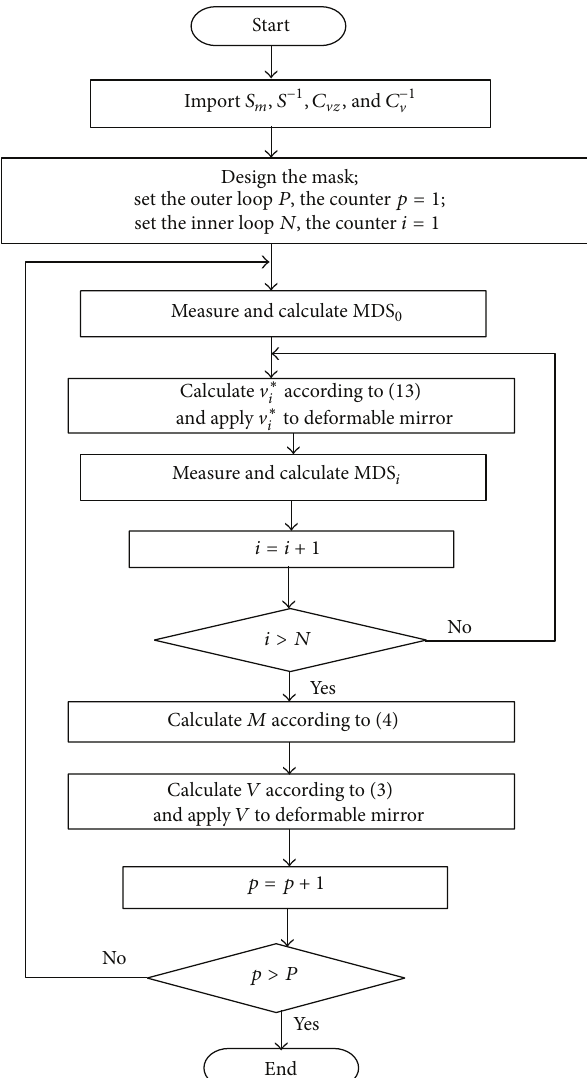
Figure 1: The flow chart of control algorithm for wavefront-sensor- less adaptive optics